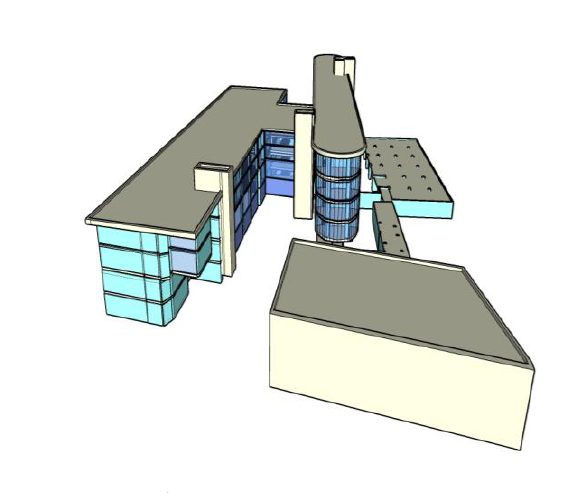
Figure 8. Scan to BIM